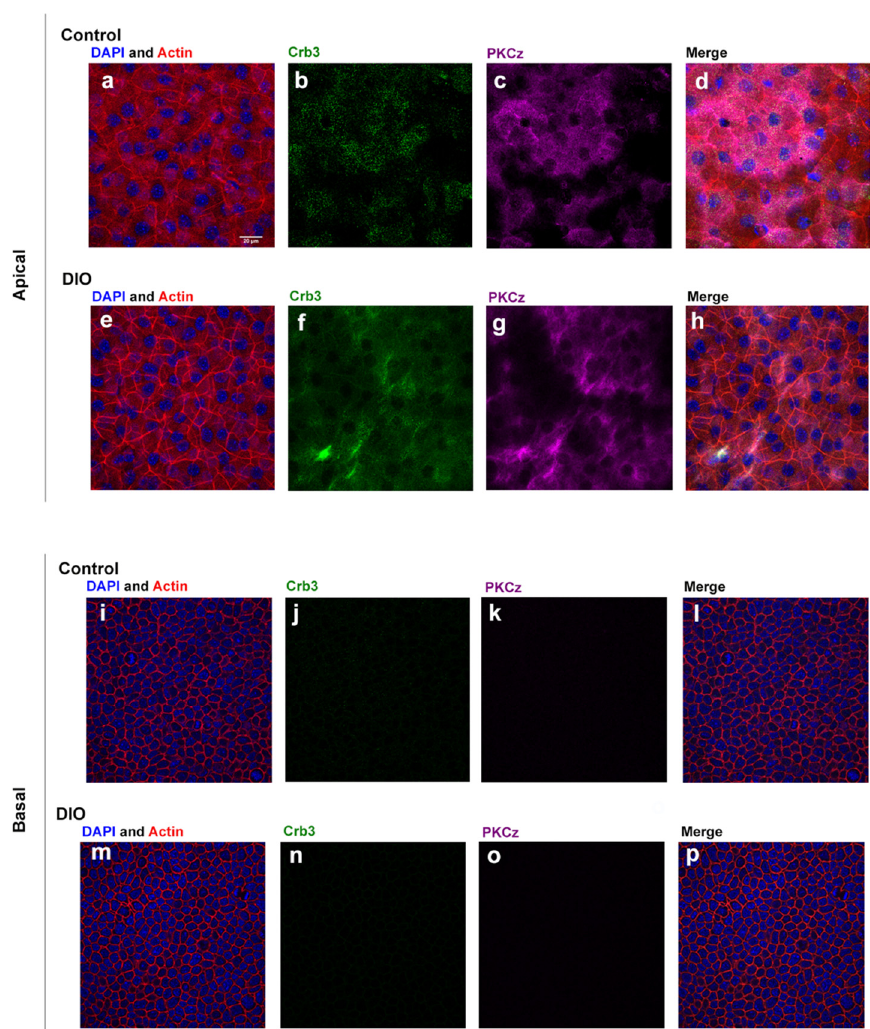
Figure 2. Localization of Crb3 and PKC ζ in unwounded control and DiO corneal epithelium. An apical and a basal image are displayed for each condition. Tissue was stained for Crb3 and PKC ζ and counter stained with rhodamine phalloidin and DAPI. Apical cells at z-plane 5 out of 25 slices, imaged at 1 µ m interval, are shown ( i – p ). Both the control ( j , k ) and DiO ( n , o ) tissue show no staining for either Crb3 or PKC ζ (Control apical-( a ). DAPI and actin, ( b ). Crb3, ( c ). PKC ζ , ( d ) merged; DiO apical-( e ). DAPI and actin, ( f ). Crb3, ( g ). PKC ζ , ( h ) merged; Control basal-( i ). DAPI and actin, ( j ). Crb3, ( k ). PKC ζ , ( l ). merged; DiO basal-( m ). DAPI and actin, ( n ). Crb3, ( o ). PKC ζ , ( p ) merged).